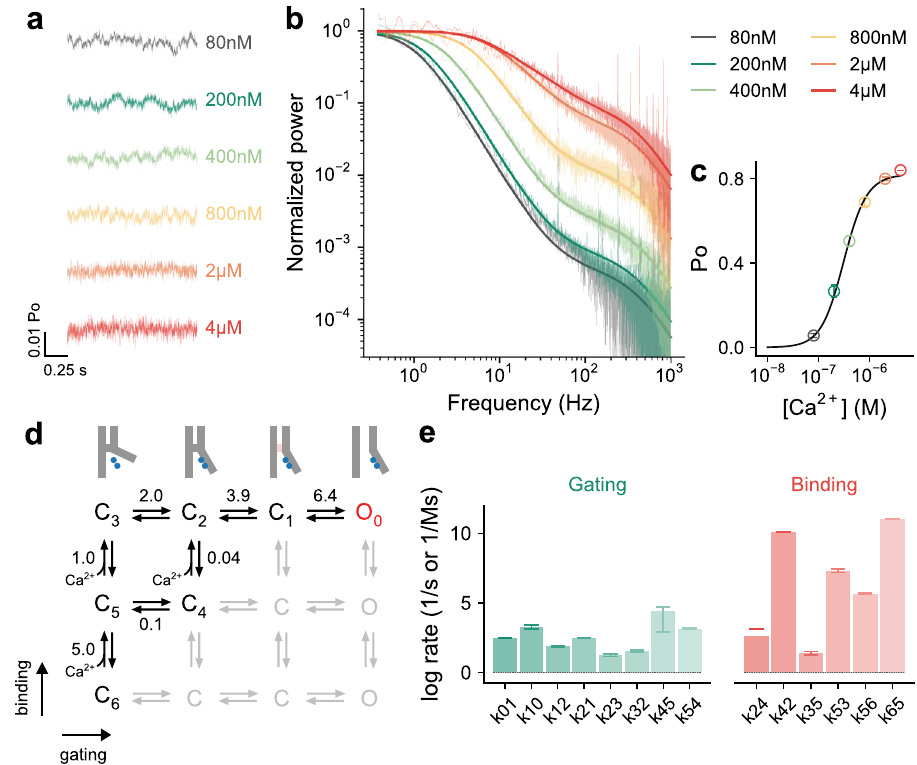
Fig. 1 Mechanistic analysis of power spectra for wild-type TMEM16A. a Representative section of the steady-state currents recorded at the indicated NiP o t ð Þ ¼ P intracellular Ca 2 + concentrations at + 80 mV. The data correspond to P O t ð Þ ¼ P O I ð t Þ (cid:1) , where I is the macroscopic current, P o the open probability, O I NiP o N the number of channels, i the unitary current, and the bar notation indicates the mean of. For display, the current traces were fi ltered at 2.5kHz using a digital 4-pole Bessel lowpass fi lter. b Power spectra of the respective steady-state currents shown in a . Data are averages of the indicated number of patches (80nM, n = 8; 200 nM, n = 8; 400 nM, n = 8; 800nM, n = 8; 2 µ M, n = 8; 4 µ M, n = 7). c Concentration-response relation. Data are averages of eight patches, errors are SEM. b , c Solid lines are the best- fi t from global optimization using the model shown in d and Supplementary Fig. 2 described by Eqs. 12 and 16. d Minimal gating model used to analyze the power spectra and concentration dependence. Best- fi t values of forward equilibrium constants and equilibrium dissociation constants ( µ M) are shown. e Kinetic parameters estimated from model fi tting. Bars indicate the best- fi t values of the averaged data shown in b and c . Errors are 95% con fi dence